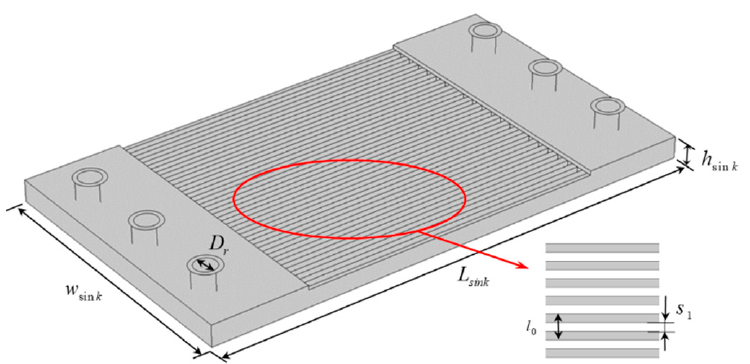
Figure 3. Geometry model of microchannel heat sink.